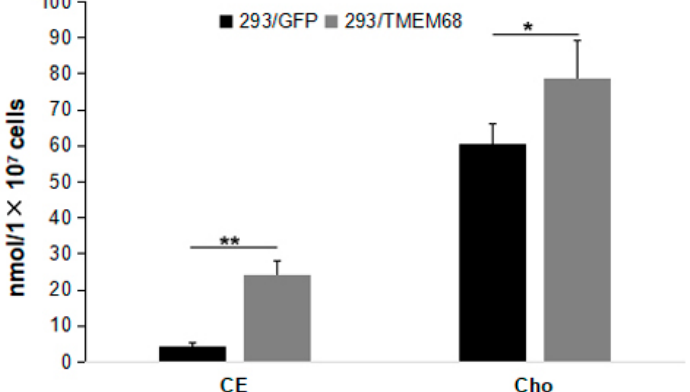
Figure 5. Quantification of cholesterol ester (CE) and cholesterol (Cho) levels in 293/TMEM68 and 293/GFP cells. Data were presented as means ± SD. Asterisk indicated p values: * p < 0.05, ** p < 0.01, n = 6.